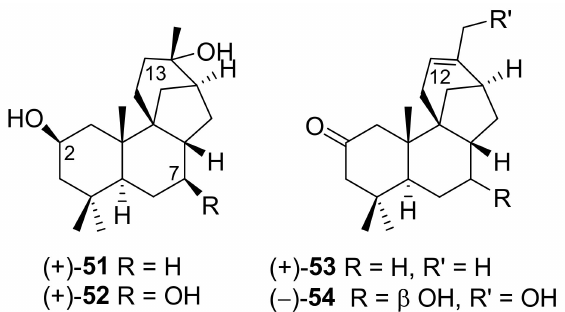
Figure 12. Stemodane diterpenoids biotransformation